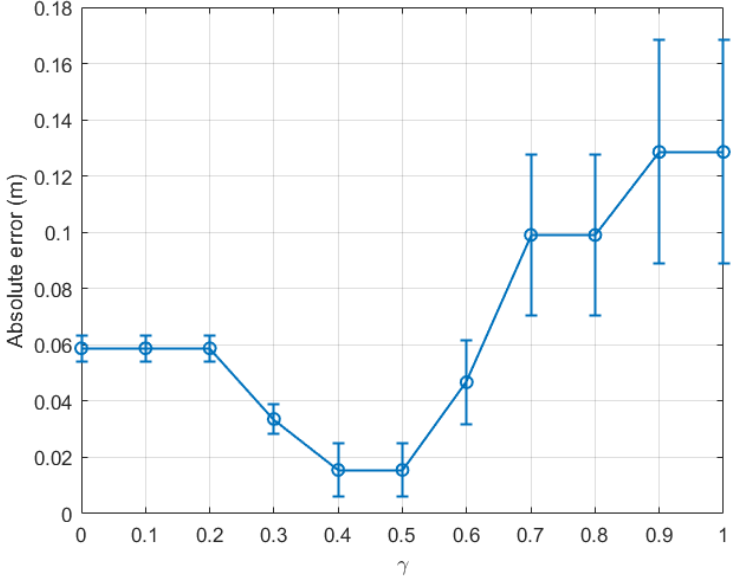
Figure 11. Outdoor walking (dataset 4): absolute error of the last time window ( tw 11 ) with respect to γ ∈ [ 0,1 ] .